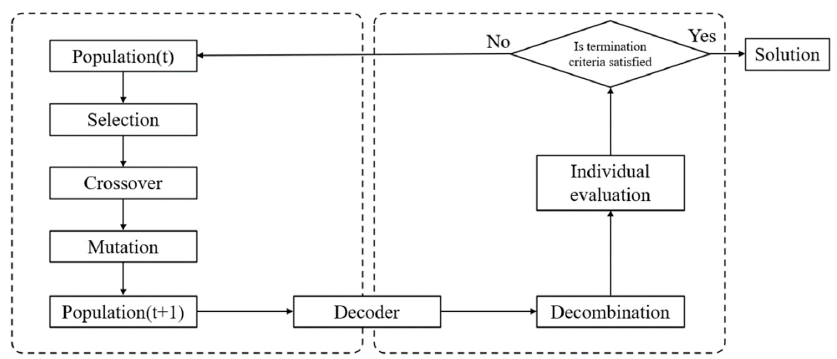
Figure 2. Genetic algorithm calculation process.